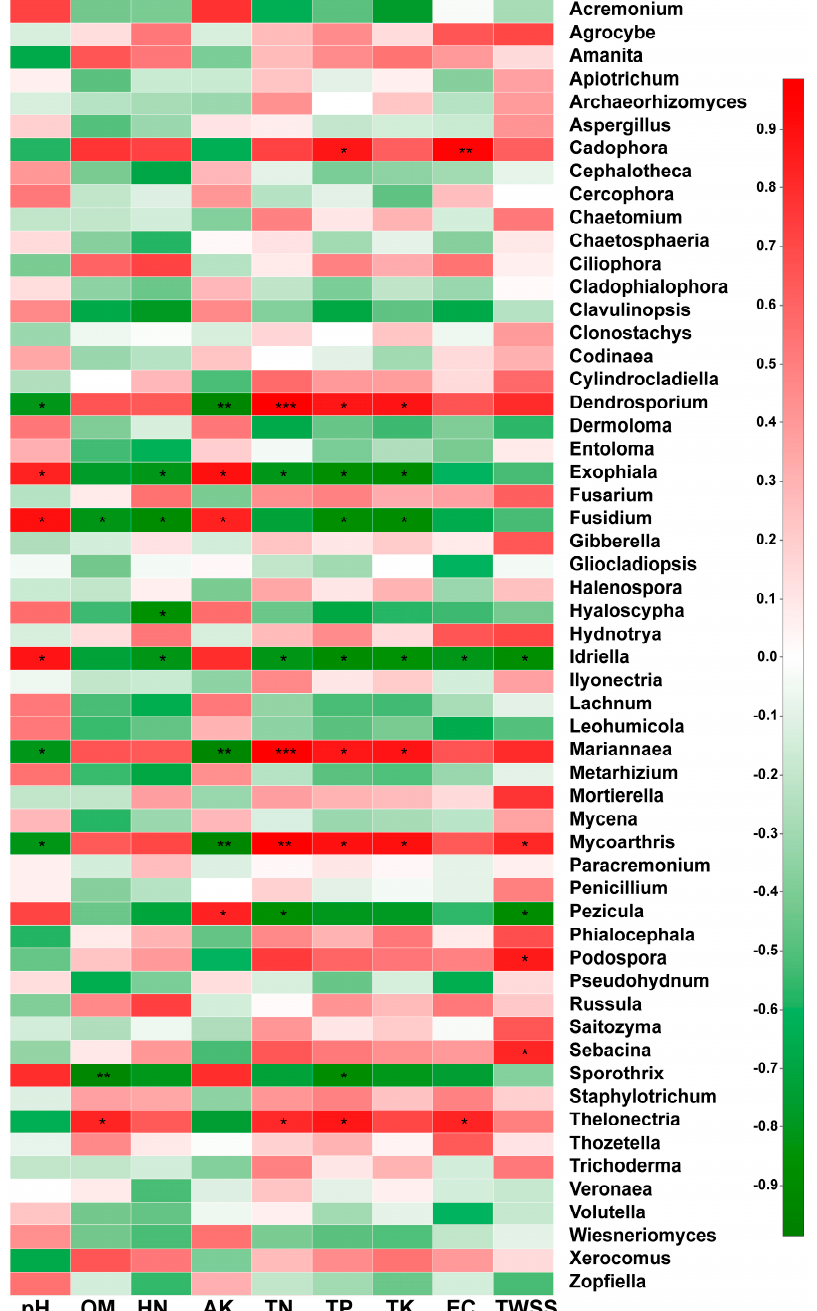
Figure 5. Spearman analysis of the relationships between soil physicochemical properties and the most abundant fungal genera in the rhizospheric soil of wild (WR) and reintroduced (RR) M. sinica at the genus level (rhizospheric soil samples from wild plants (WR, n = 3); rhizospheric soil samples from reintroduced plants (RR, n = 3); * 0.01 < P ≤ 0.05, ** 0.001 < P ≤ 0.01, *** P ≤ 0.001.